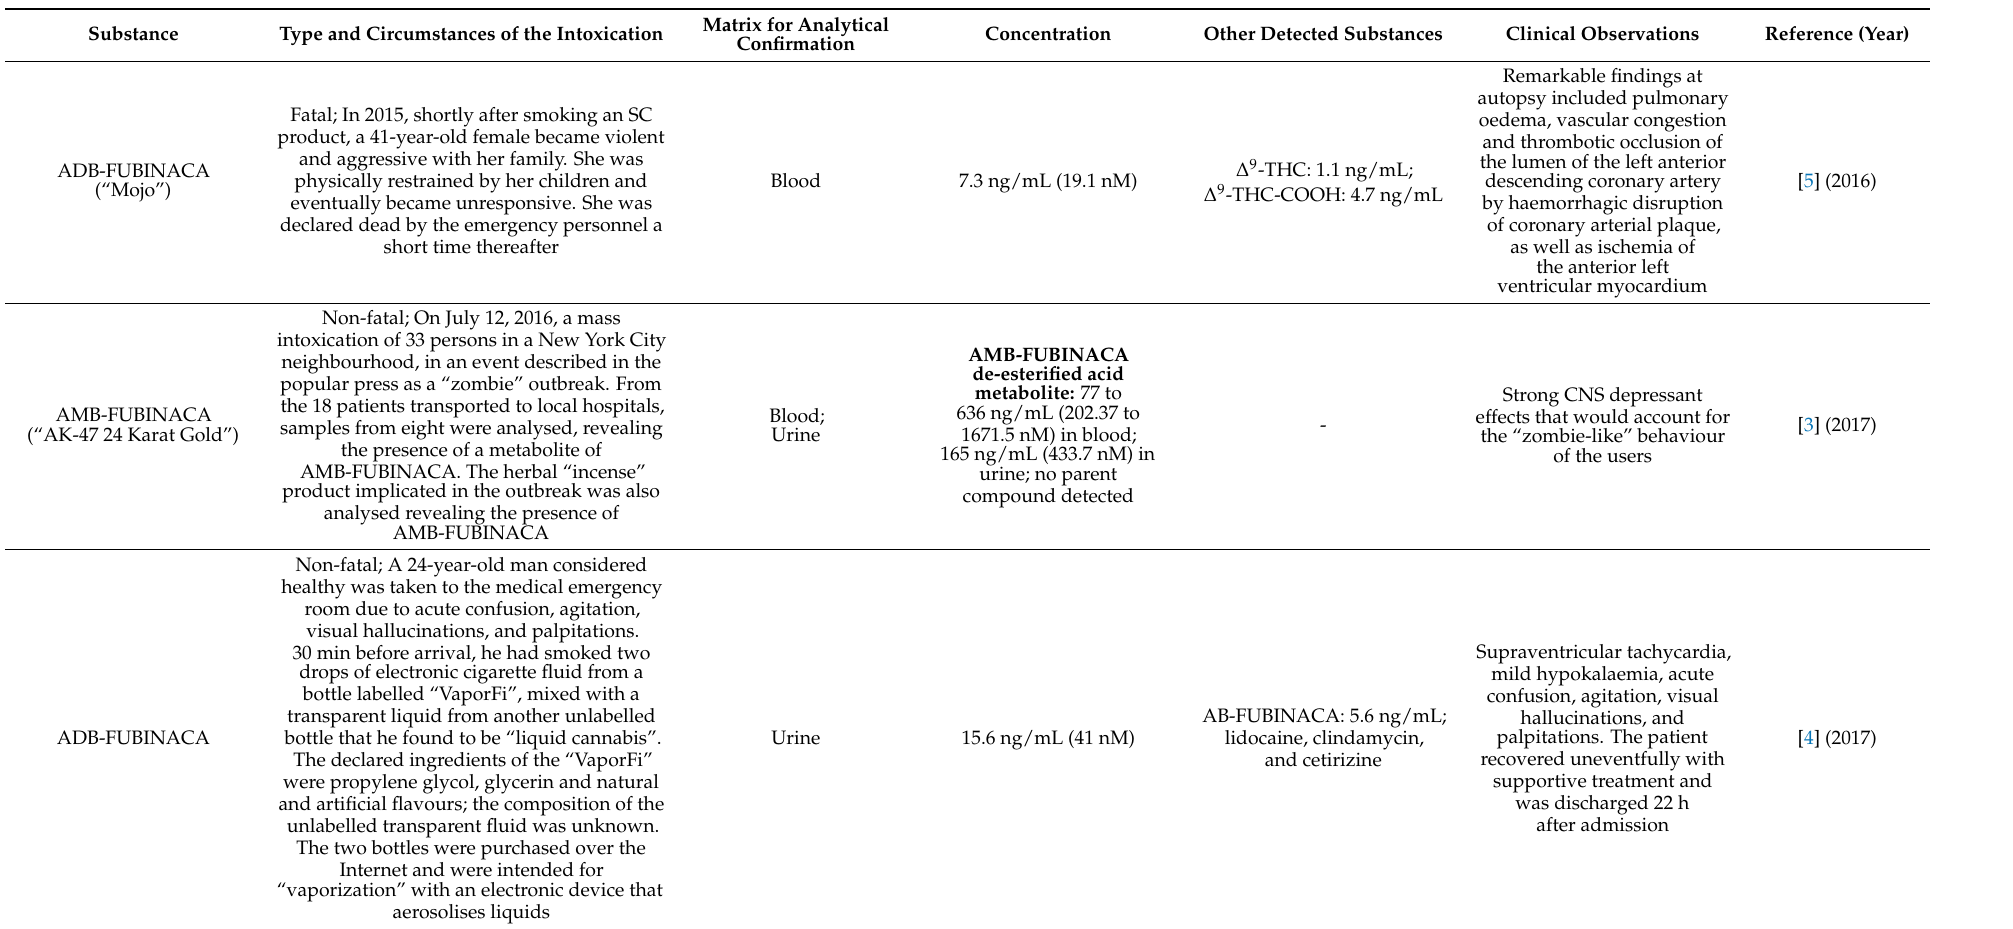
Table 4. Reported intoxications for ADB-FUBINACA and